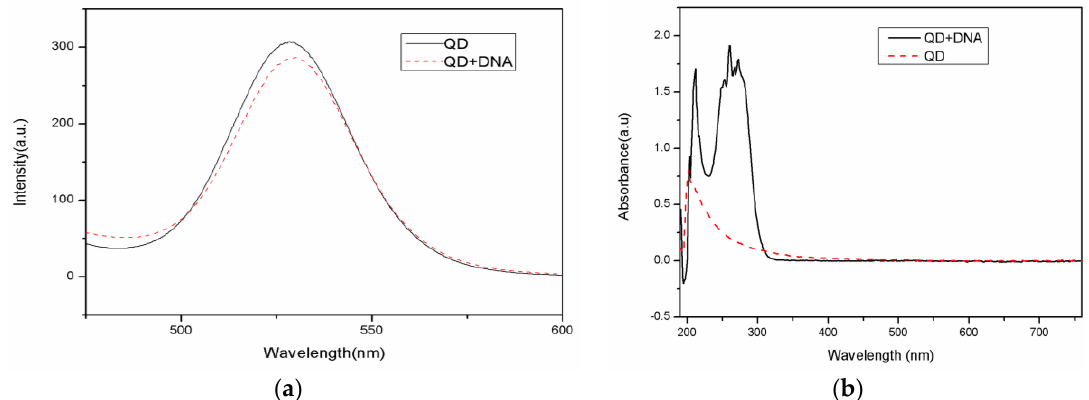
Figure 3. Fluorescence and absorption spectra of QD and the QD-labeled DNA: QD represents the fluorescence spectrum of the quantum dots, QD + DNA represents the fluorescence spectrum of the quantum dot-labeled DNA. ( a ) fluorescence spectra; ( b ) absorption spectra.